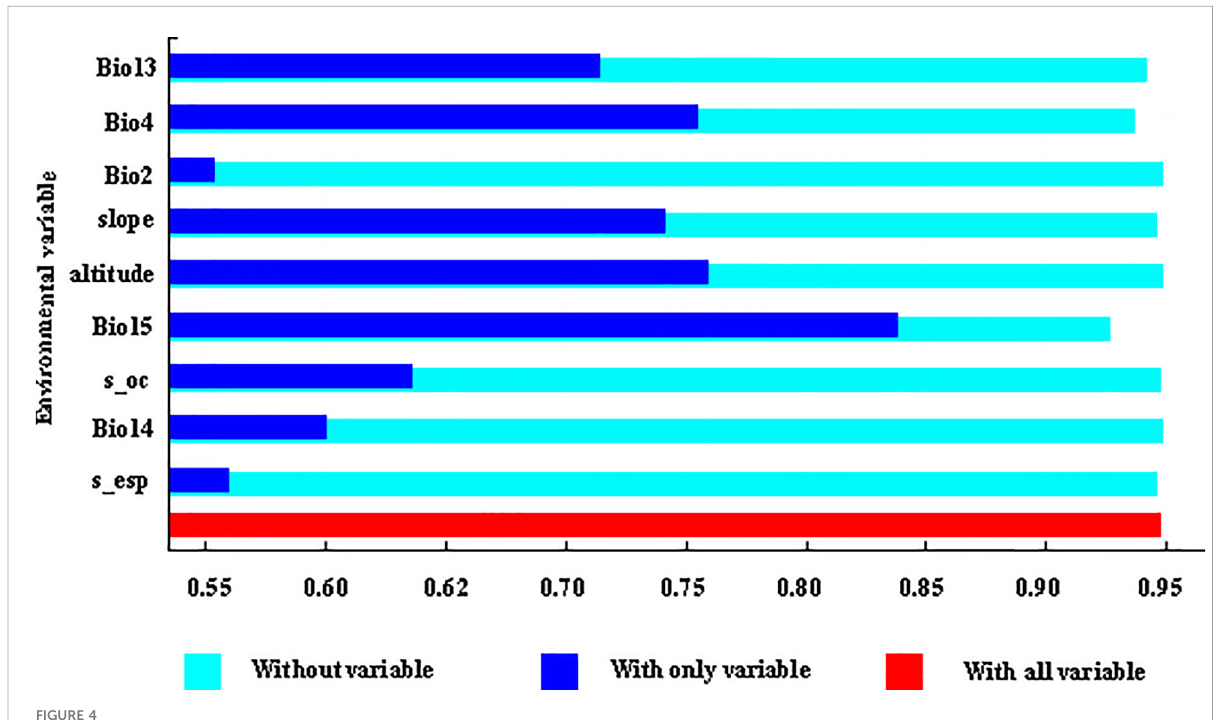
FIGURE 4 Veri fi cation results of the naked oat environmental factor knife cutting method.